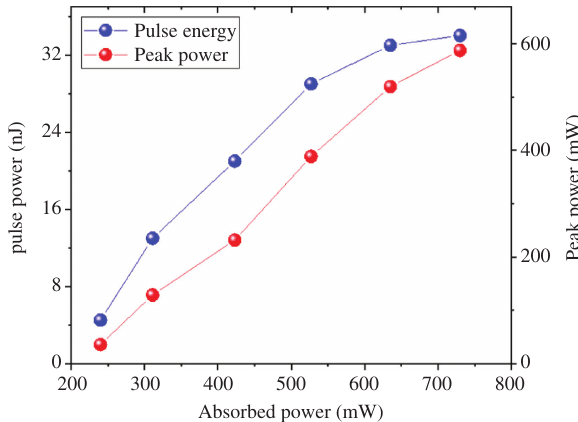
Figure 9: The pulse energy and pulse peak power varying with absorbed